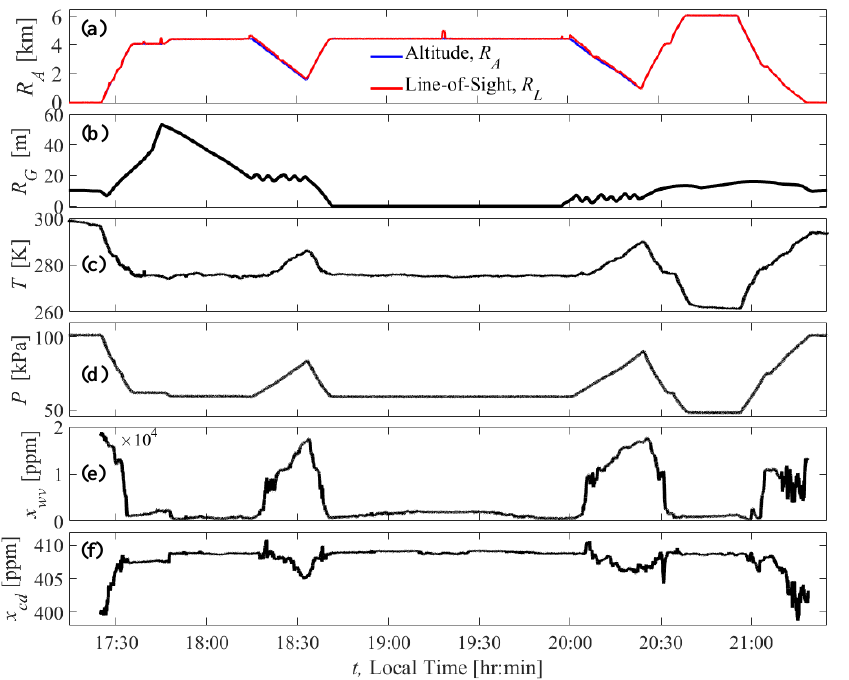
Figure 5. Flight ground track (blue) recorded using GPS for NASA B-200 aircraft on 17 September 2019 between Hampton, VA (37.0299° N, 76.3452° W) and Wilmington, NC (34.2104° N, 77.8868° W)